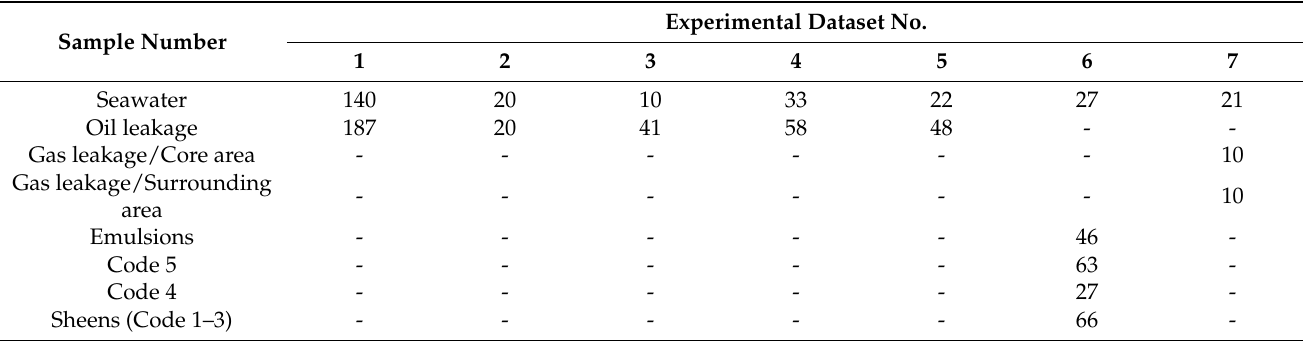
Table 4. Samples of the experimental